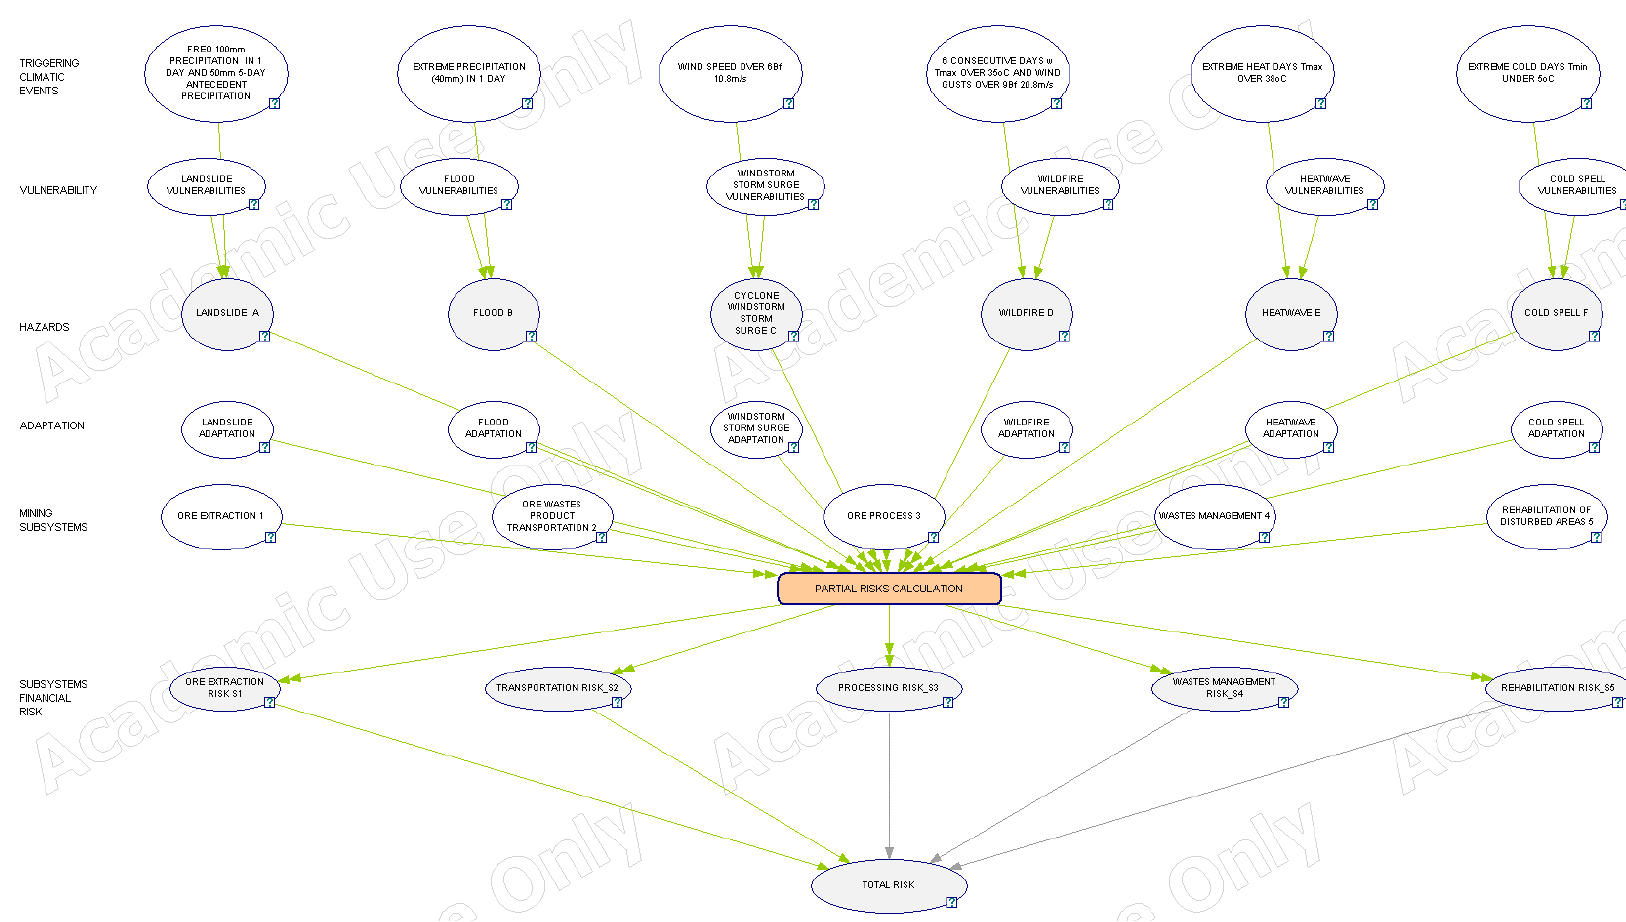
Figure 2. General layout of the CLIRMI Bayesian belief network (BBN).